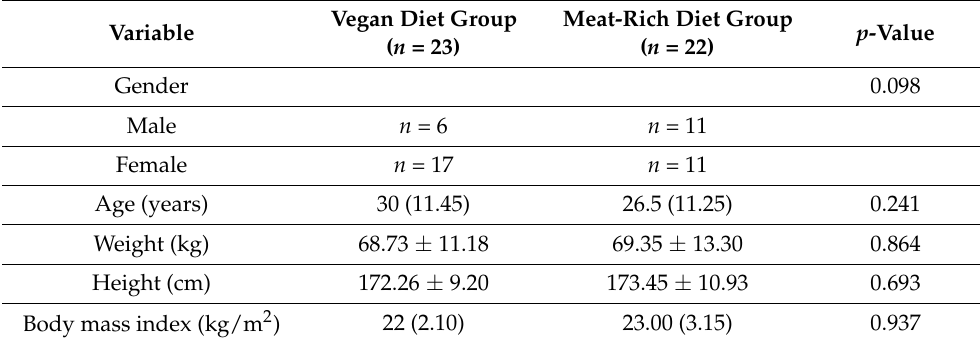
Table 1. Participants’ baseline data. Normally distributed data are shown as mean ± standard deviation; not normally distributed data are shown as medians (interquartile range). Chi-Square Test was used to calculate p -values for gender.